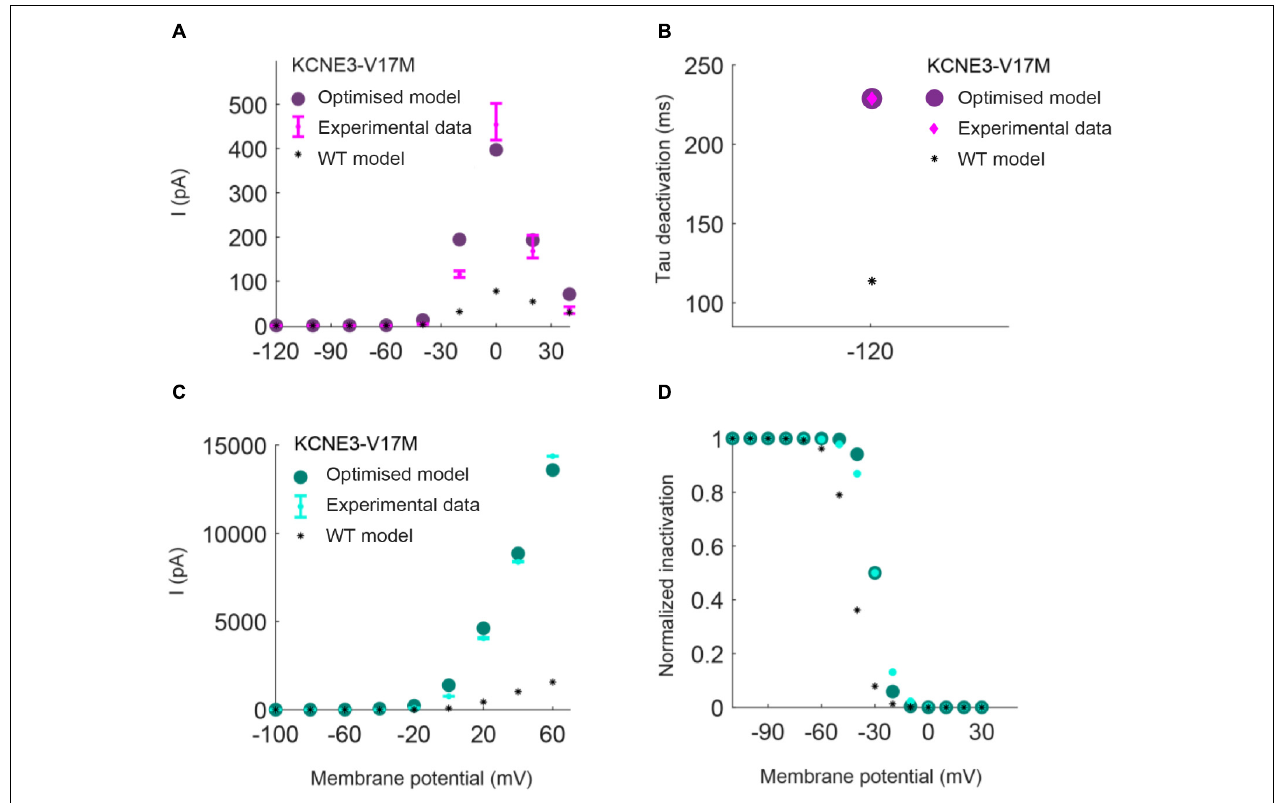
FIGURE 3 | Resulting I Kr (top) and I to (bottom) I/V relationship and inactivation curves obtained by using the parameters estimated with the optimization procedure of the Kv11.1/KCNE3-V17M mutation (purple) and Kv4.3/KCNE3-V17M mutation (green). Error bars indicate experimental data (target) and closed circles correspond to simulation results; wild-type (WT) model results are represented by black stars. (A,C) I–V relationships. (B) Deactivation time constant at − 120 mV. (D) Steady-state inactivation